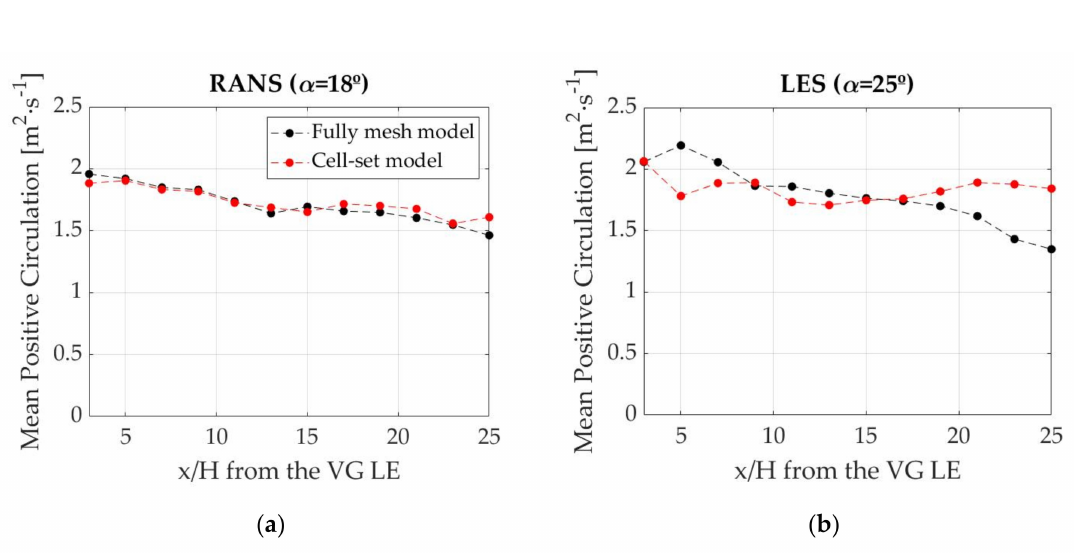
Figure 10. Mean positive circulation of the primary vortex: ( a ) RANS; ( b ) LES.